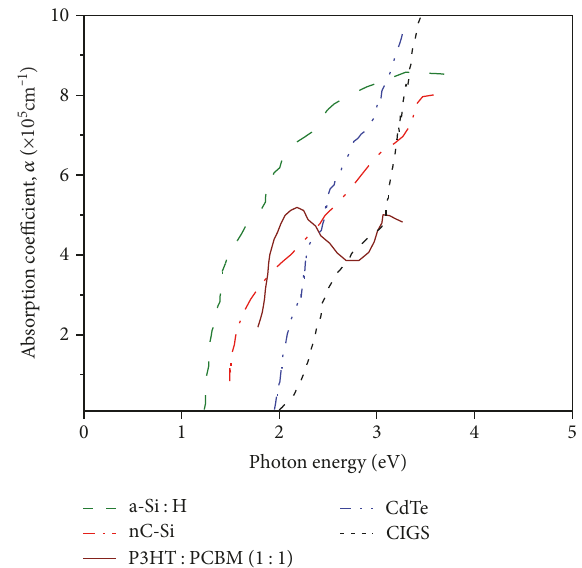
Figure 3: Comparison of absorption coe ffi cients for the commonly used solar cell photoactive absorber materials